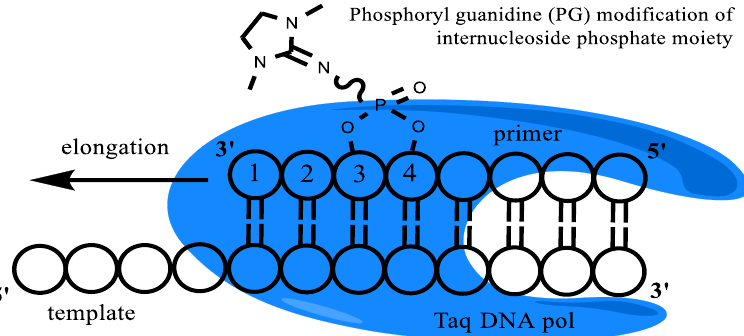
Figure 1. Taq-polymerase and template/modified primer complex schematic representation. An ex- ample of PG modification is presented. example of PG modification is